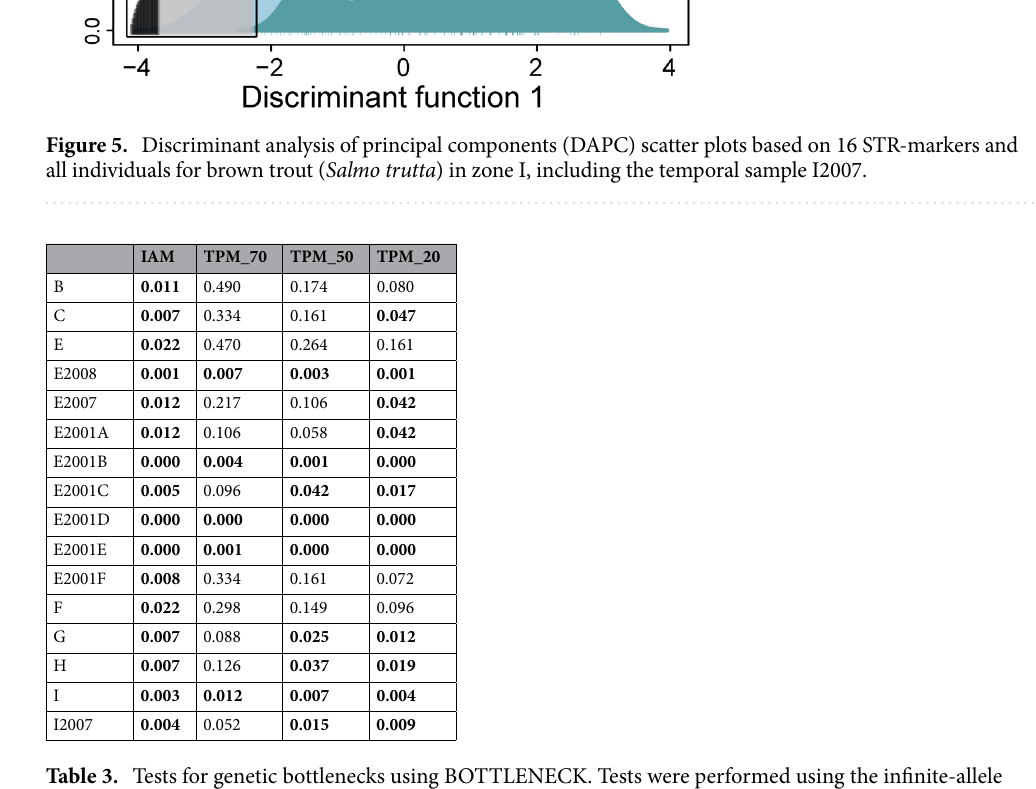
Table 3. Tests for genetic bottlenecks using BOTTLENECK. Tests were performed using the infinite-allele model and the two-phase mutation model (TPM). For the latter, different proportions of STR loci that follow the stepwise mutation model were used (i.e., 70, 50, and 20%, respectively). P-values according to a 1-way Wilcoxon rank test for heterozygote excess are given and significant values are highlighted in bold